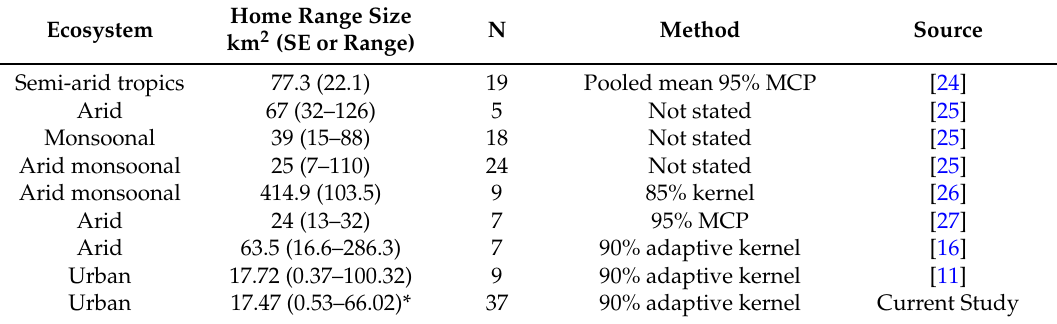
Table 1. Home range sizes of wild dogs in rural, urban and wilderness areas of northern Australia (adapted from Fleming et al. 2012 [23]). * Exclusive of animals monitored for <20